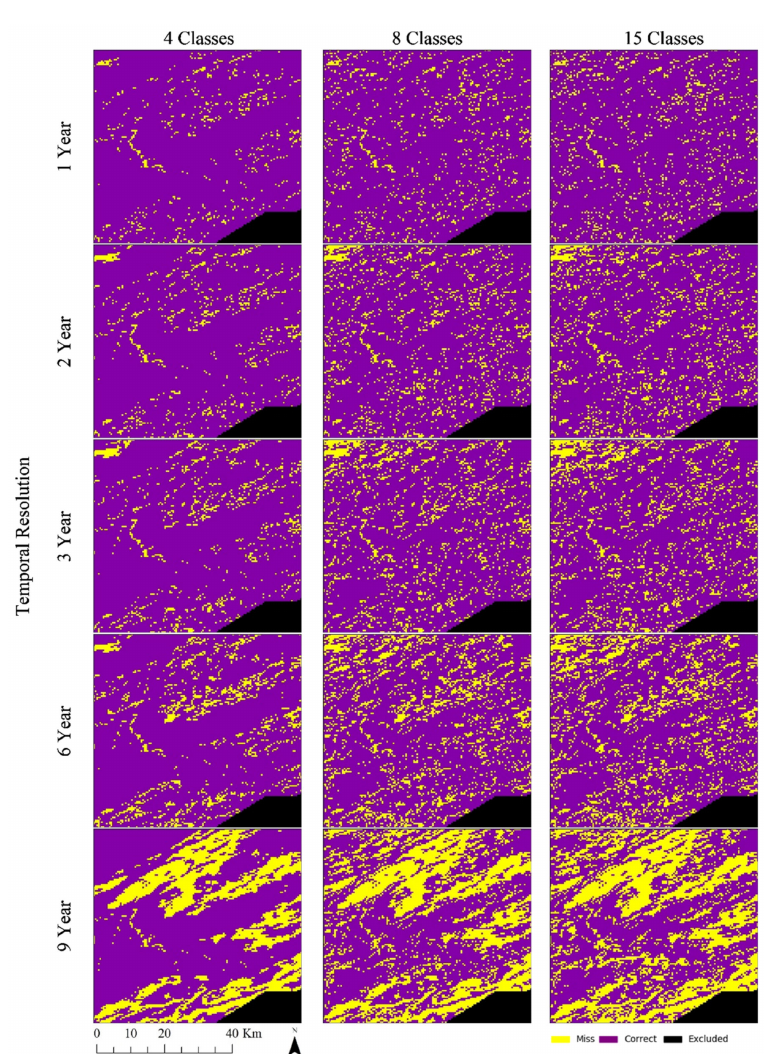
Figure 8. Forecasting errors in simulated outputs from models considering the real-world LC data featuring 4, 8, and 15 classes. The area shown focusses on the City of